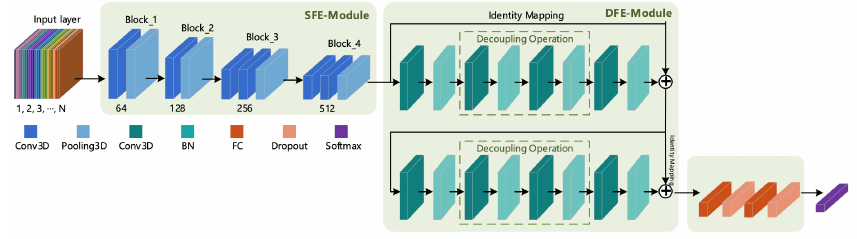
Figure 1. Architecture of the Residual 3D model